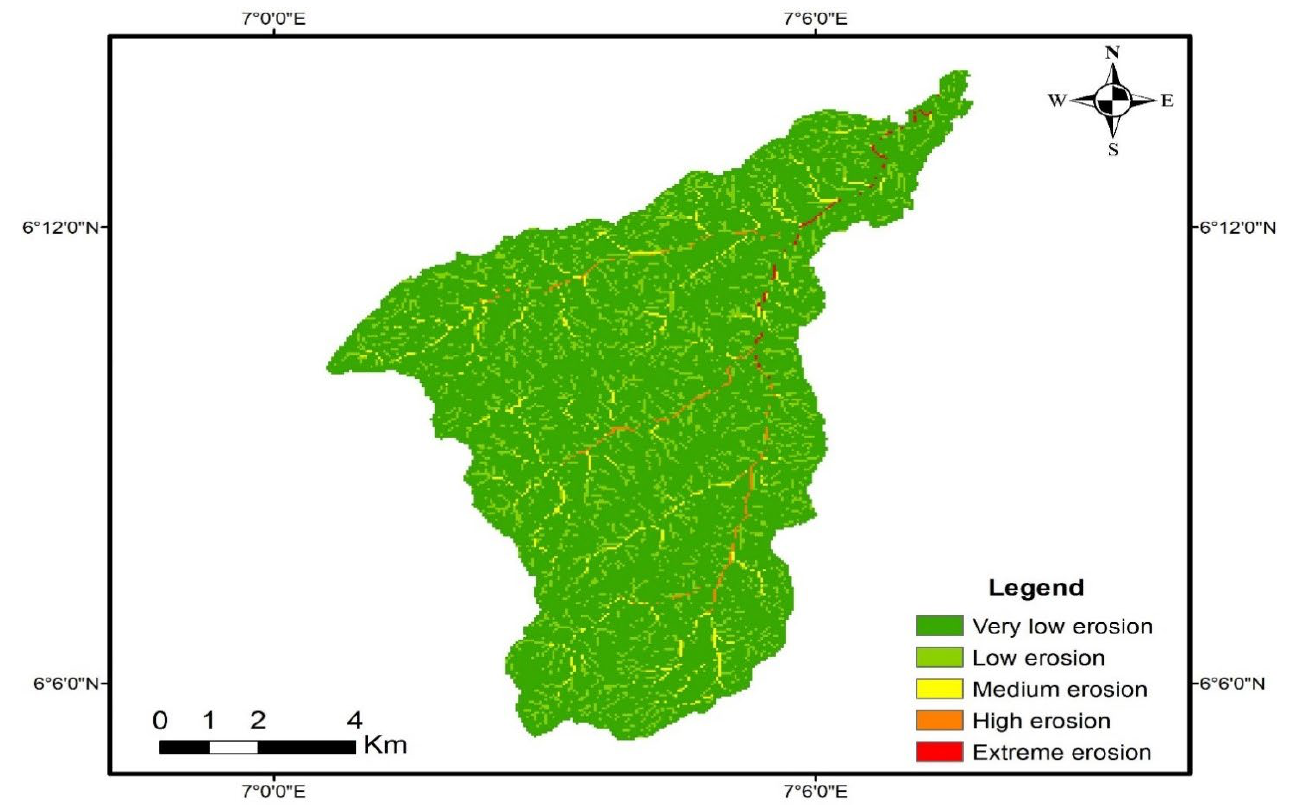
Figure 4. Erosion risk map of Obibia River watershed